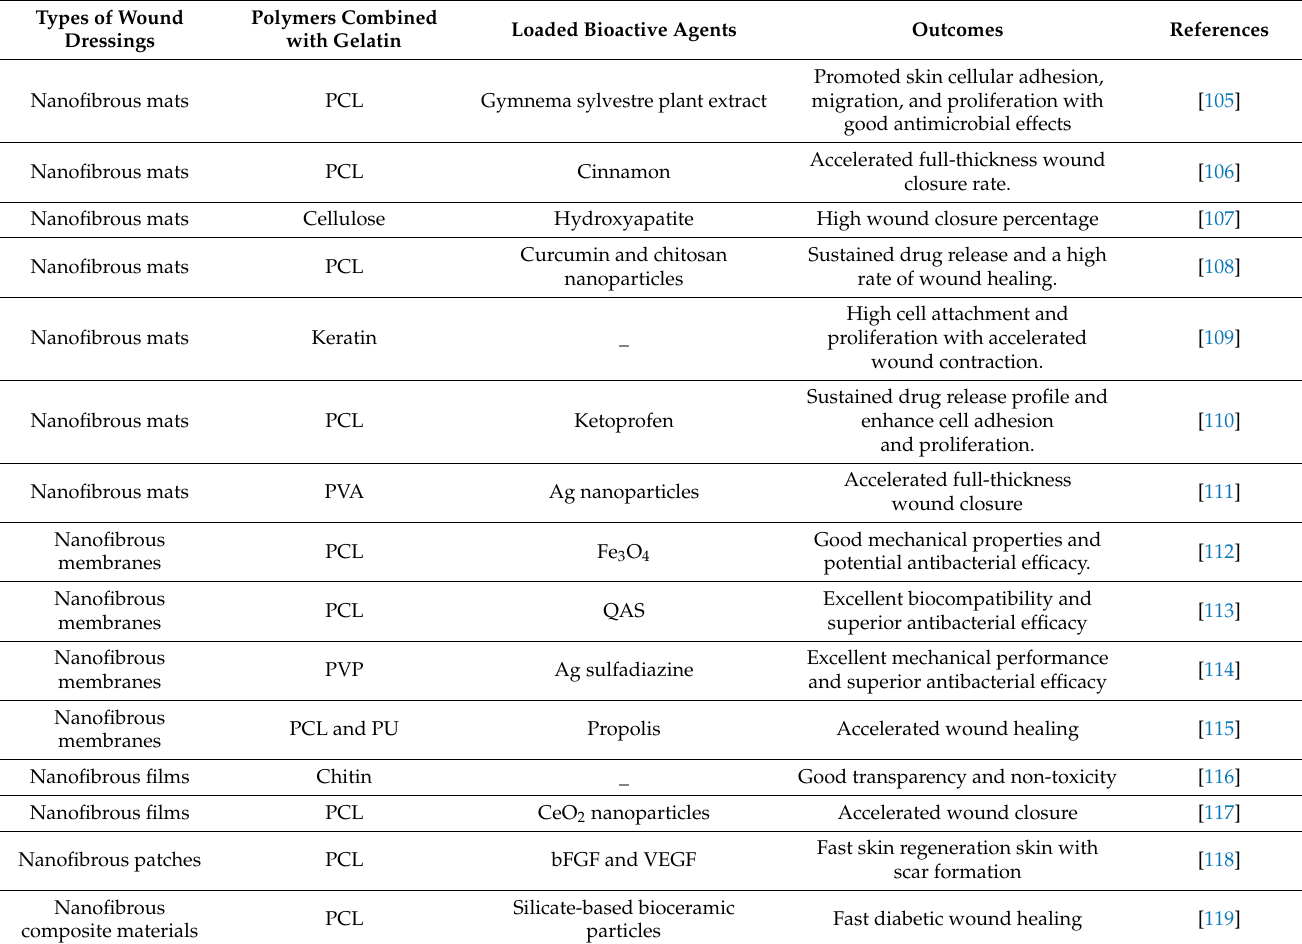
Table 4. Gelatin-based hybrid nanofiber Wound